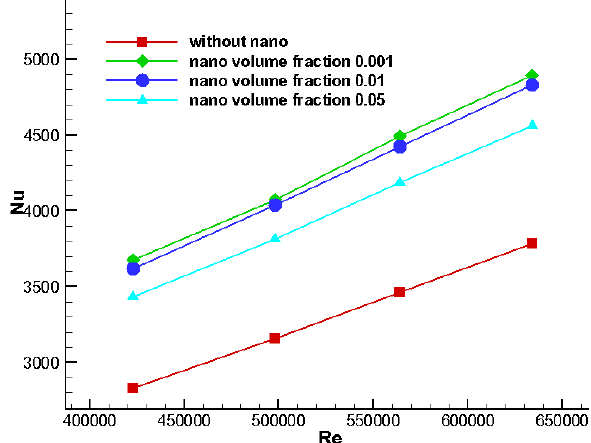
Fig. 14. Nusselt number for various particle volume concentrations Fig .14 Nusselt number for various particle volume concentrations